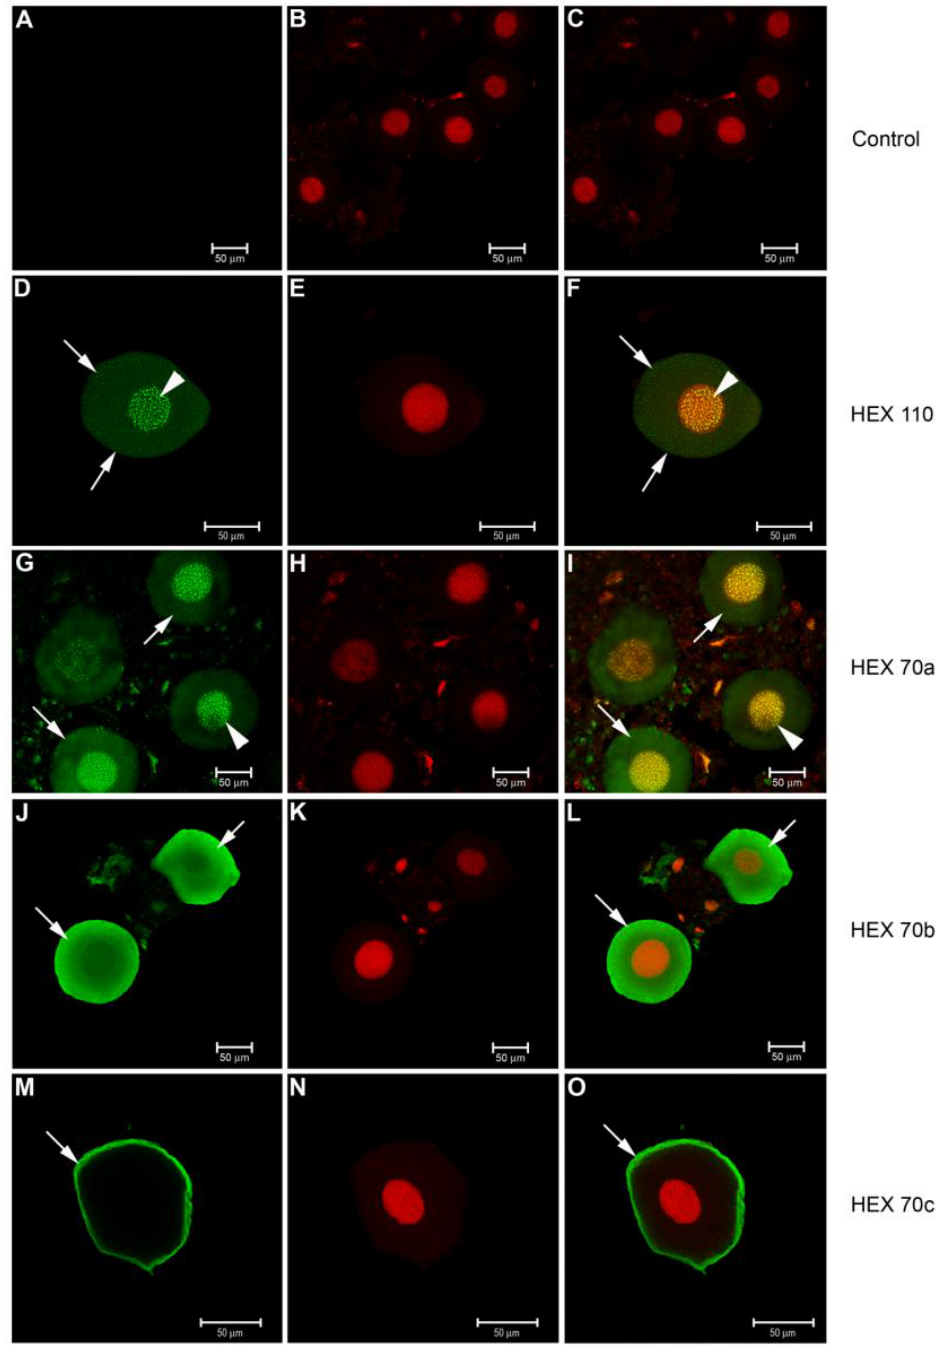
Figure 4. Confocal microscopy for detection of hexamerins in the fat body oenocytes of pharate pupae (PP phase). Alexa Fluor 488-stained enocytes: preparations ( A ) without the specific (primary) antibody (control) or with ( D ) anti-HEX 110, ( G ) anti-HEX 70a, ( J ) anti-HEX 70b or ( M ) anti-HEX 70c for detection of the respective hexamerins (green foci). ( B , E , H , K , N ) Propidium iodide-stained cell nuclei (red). At the right column, the merged images show: ( C ) the control without the antibody, ( F ) HEX 110 and ( I ) HEX 70a mainly in the nuclei (yellow foci) but also in the cytoplasm (green foci), ( L ) HEX 70b in the cytoplasm (green foci), ( O ) HEX 70c at the cytoplasmic periphery (green foci). Arrowheads: nuclear foci of hexamerins. Arrows: hexamerin foci in the